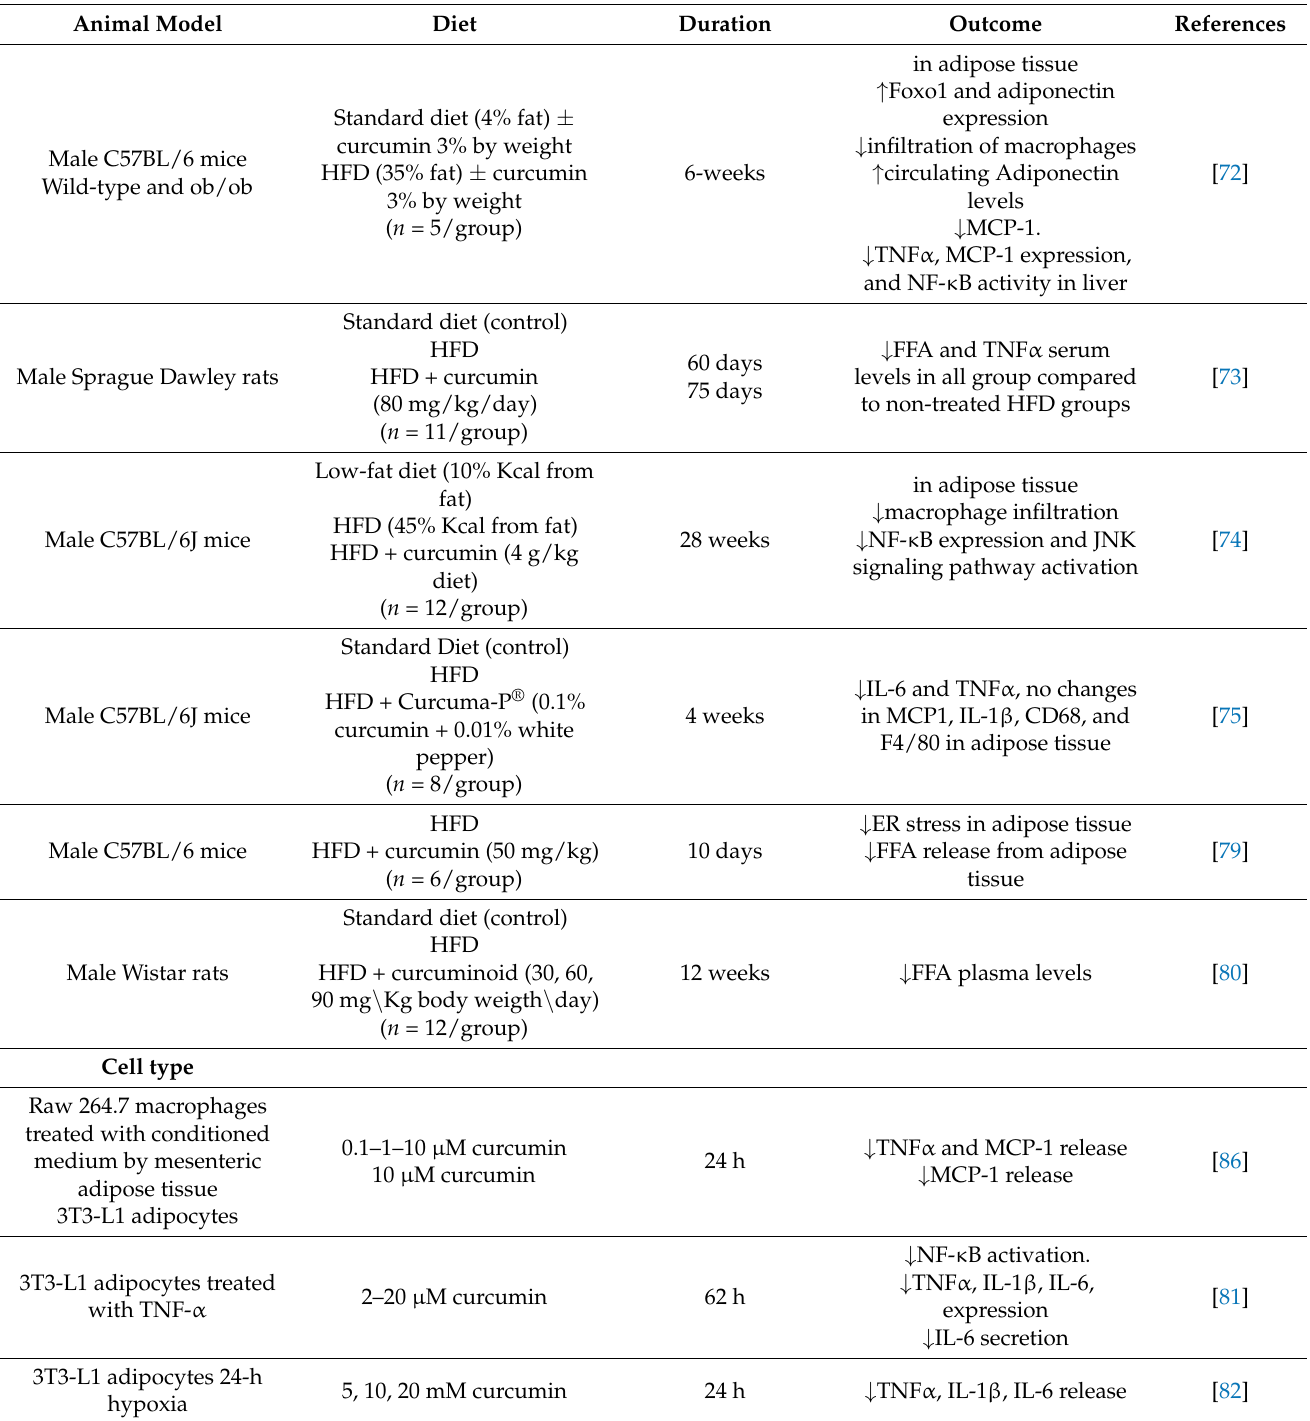
Table 2. Effects of curcumin on inflammation in obesity: in vivo and in vitro